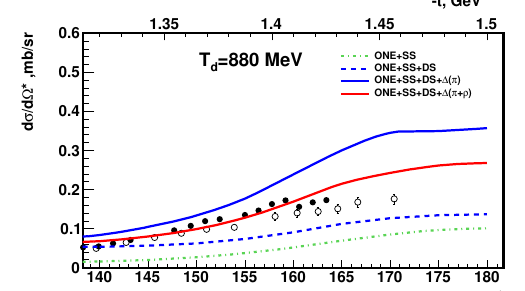
= 1000 MeV. d = 940 MeV, • - [ 24 ] at d